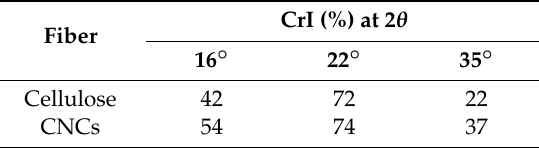
Table 1. CrI values for cellulose and CNC XRD